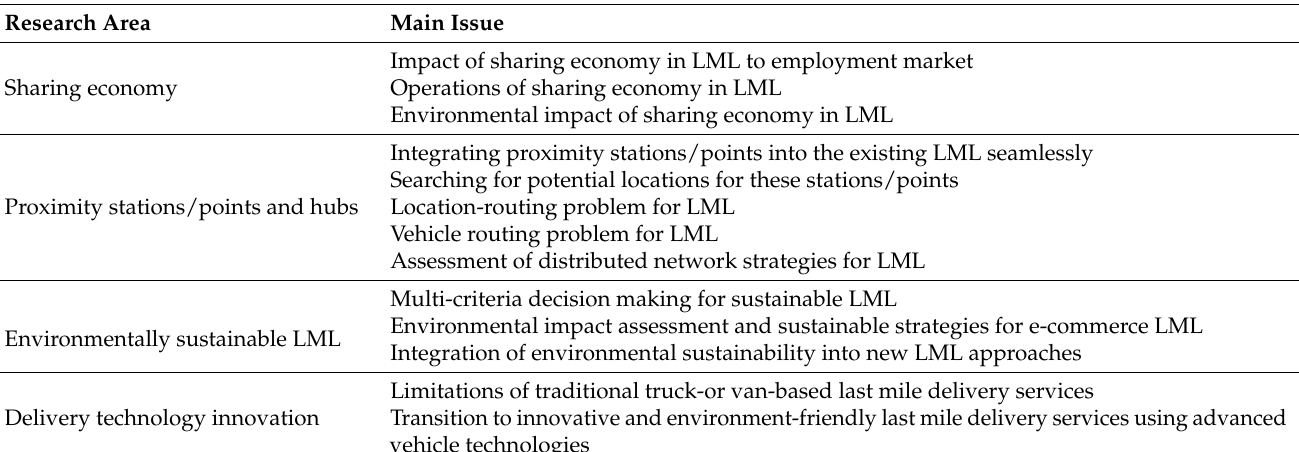
Table 2. Typology of LML-related